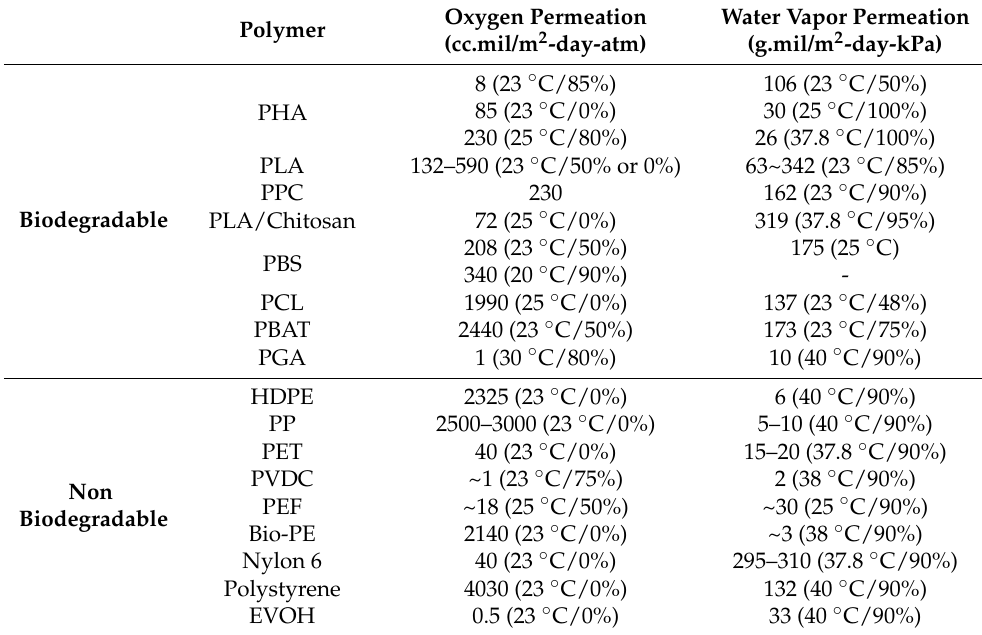
Table 3. Summary of the oxygen/moisture barrier properties of polymers. Data from